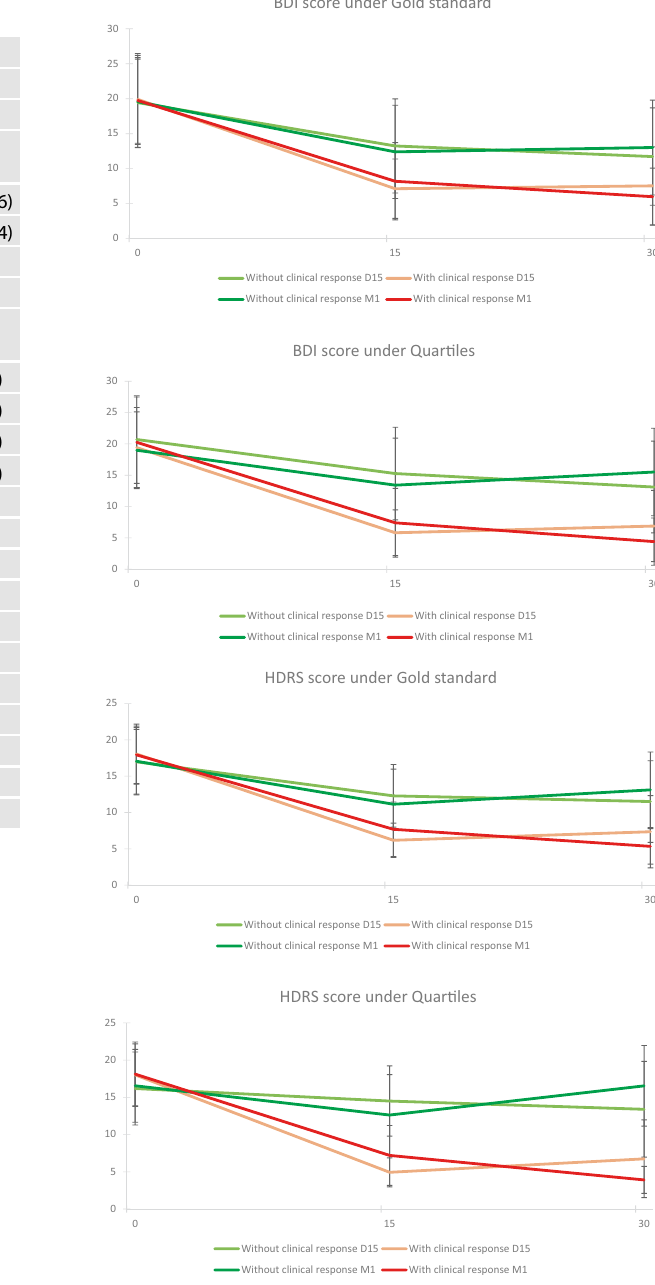
Fig. 3 Clinical response based on the evolution of the HDRS and BDI psychometric scales scores under gold standard and quartiles